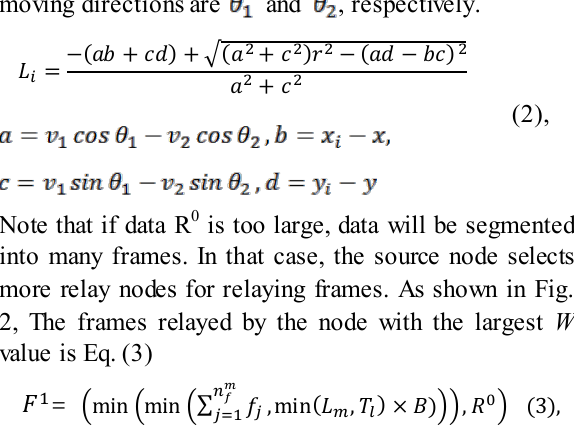
Fig. 1. FAB computes the W values to decide the next